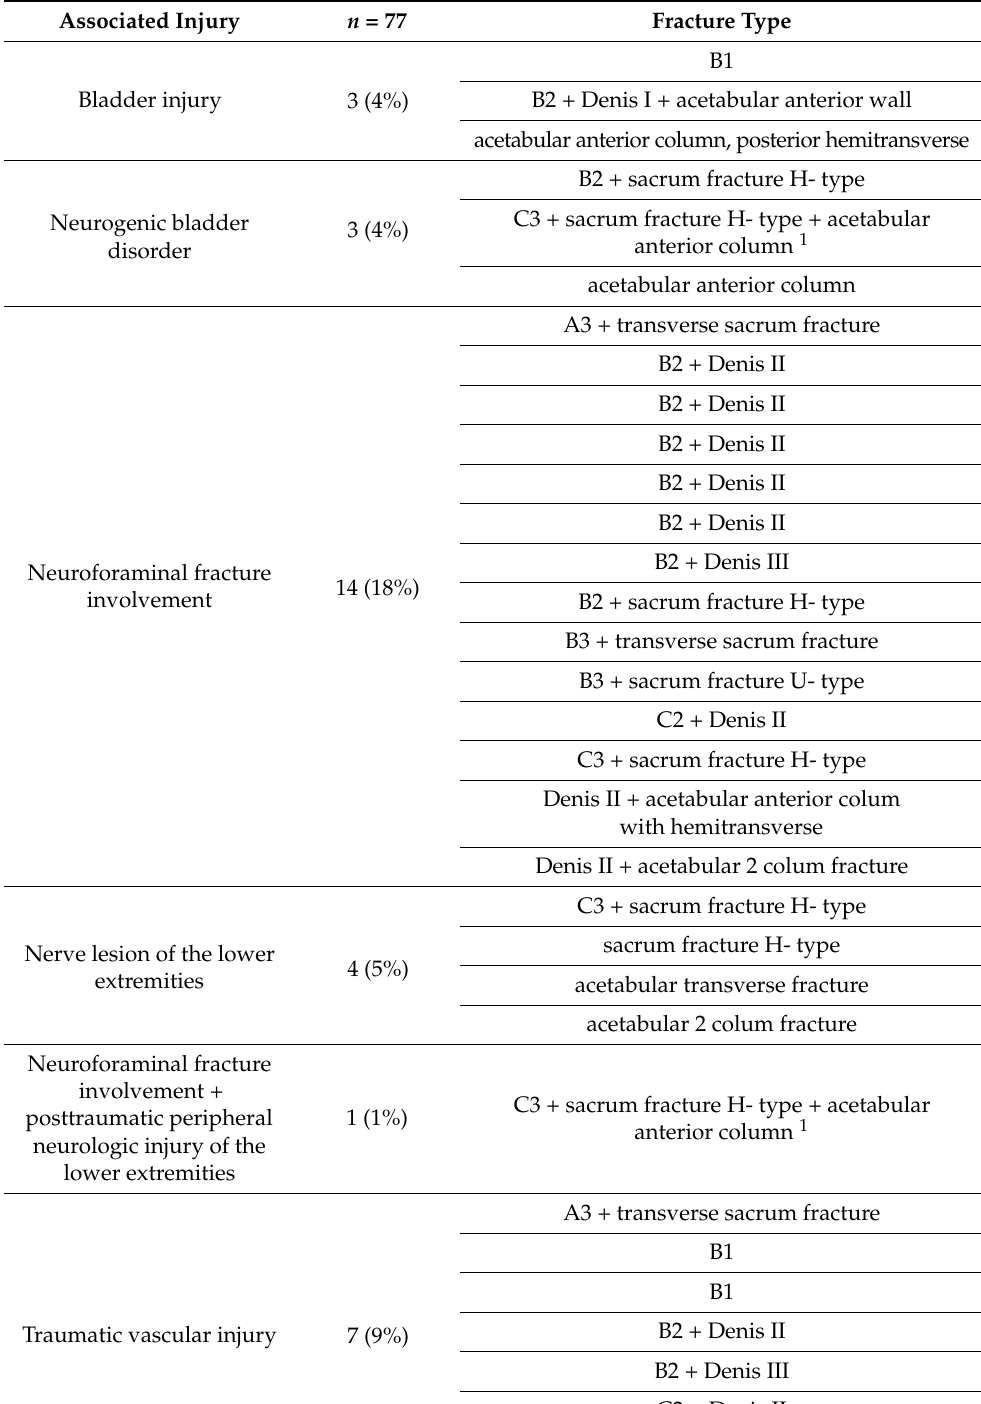
Table 5. Associated injuries of pelvic